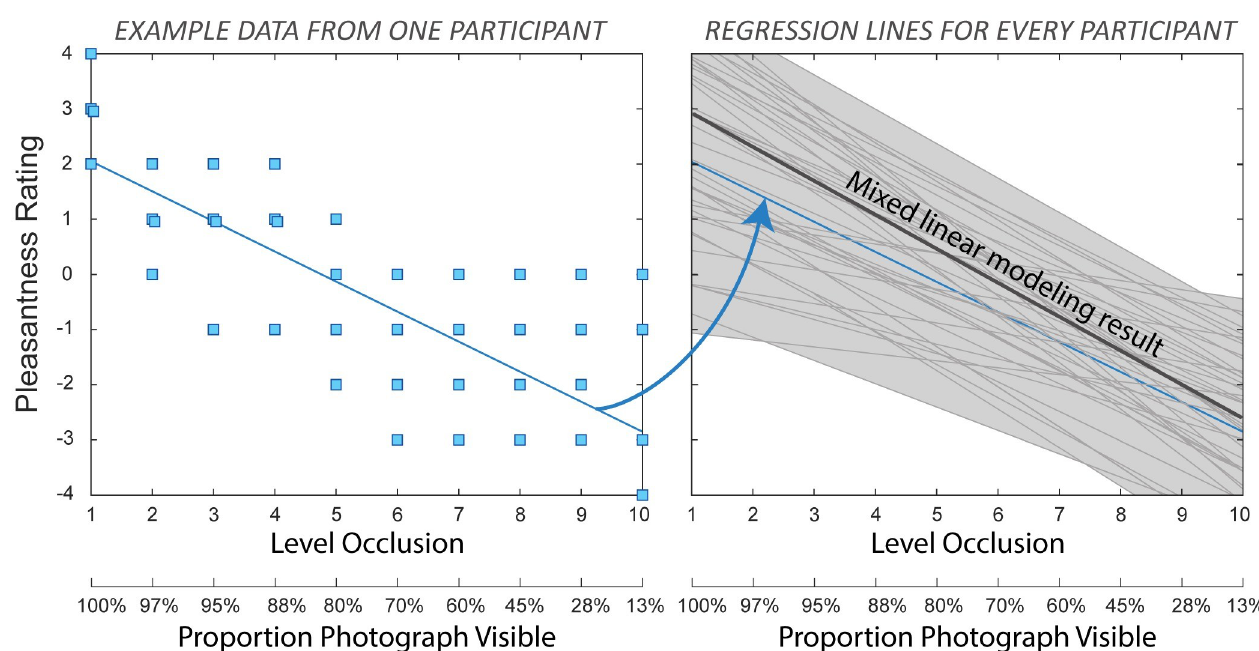
Fig 7. Relation between pleasantness ratings and level of occlusion of the photographs. An example of a dataset obtained for one participant is presented in the left panel. Regression lines obtained for all participants are presented in the right panel. Absolute values of correlations between pleasantness ratings and occlusion levels are used as input in subsequent analyses to represent individual differences in reward